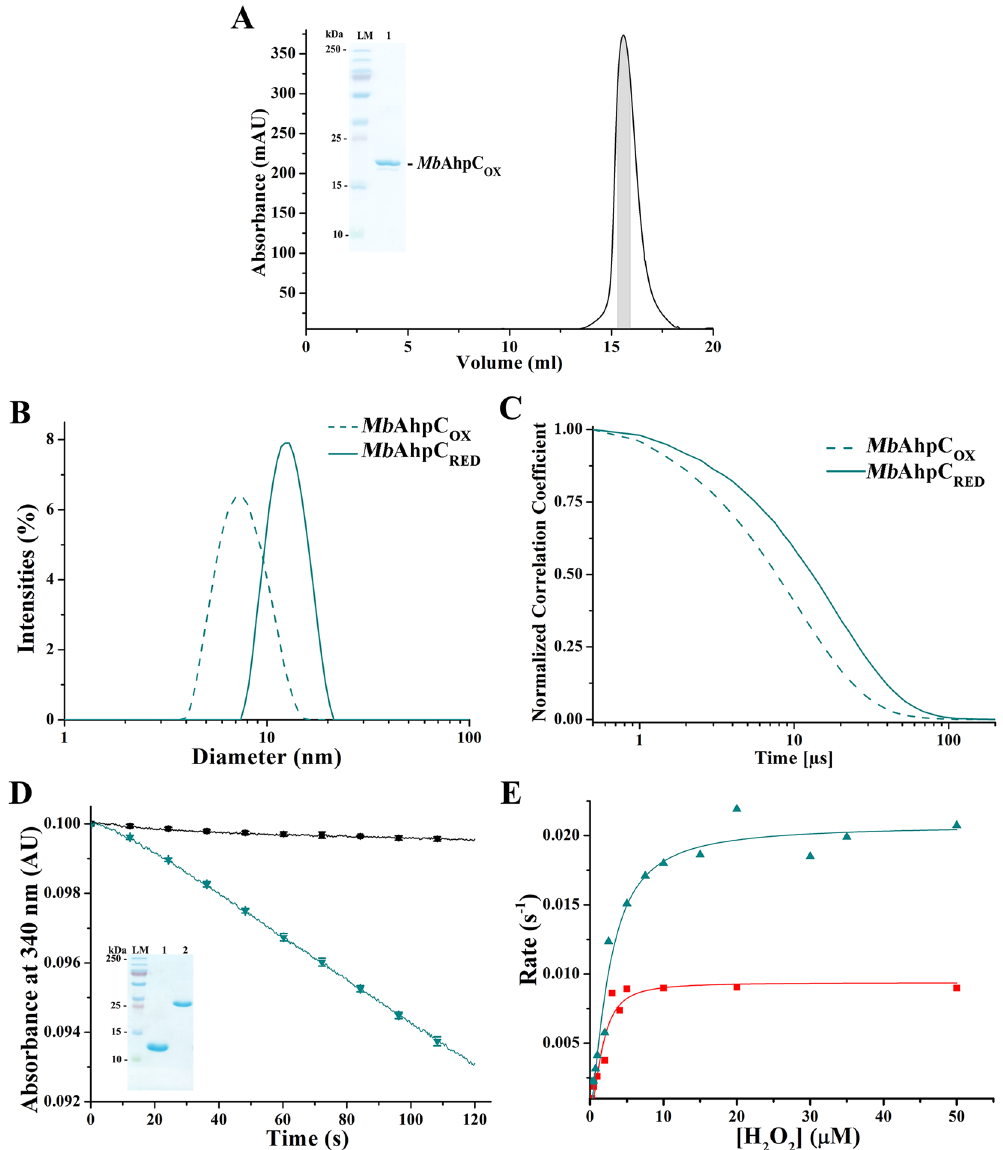
Figure 2. Protein characterization of Mb AhpC. ( A ) The recombinant and oxidized Mb AhpC eluted at approximately 16 ml on a Superdex 200 HR 10/30 column and showed high purity on a 17% SDS gel ( inset ). ( B ) DLS analysis of the oxidized ( green dashed line ) and reduced ( green solid line ) Mb AhpC. ( C ) Normalized correlation function of DLS studies of Mb AhpC in 50 mM Tris/HCl, pH 7.5, 200 mM NaCl. A slowed relaxation of the autocorrelation curve in reduced Mb AhpC ( green solid line ) was observed as compared with oxidized Mb AhpC ( green dashed line ). ( D ) NADPH-oxidation of Mb TrxC and Mb AhpC. The control experiment was performed in the absence of enzymes and H 2 O 2 ( black solid line ). The utilized Mb TrxC ( lane 1 ) and Mb TrxB2 ( lane 2 ) showed high purity on a 17% SDS gel ( inset ) after size exclusion chromatography purification. The size of Mb TrxC is 12,203 Da and Mb TrxB2 is 35,643 Da. A significant drop in absorbance was observed due to the presence of wt Mb AhpC ( green solid line ). ( E ) The Michaelis-Menten plot of Mb AhpC and Mb AhpC T5A/D8A were performed by fitting data of at least ten concentrations of H 2 O 2 to establish the enzymatic kinetic parameters of wt Mb AhpC and Mb AhpC T5A/D8A . Mb AhpC showed a higher enzymatic efficiency ( green line and triangle symbols ) as compared to Mb AhpC T5A/D8A ( red line and square symbols ) whereby the reaction approached V max rapidly in the mutant as compared to wt Mb